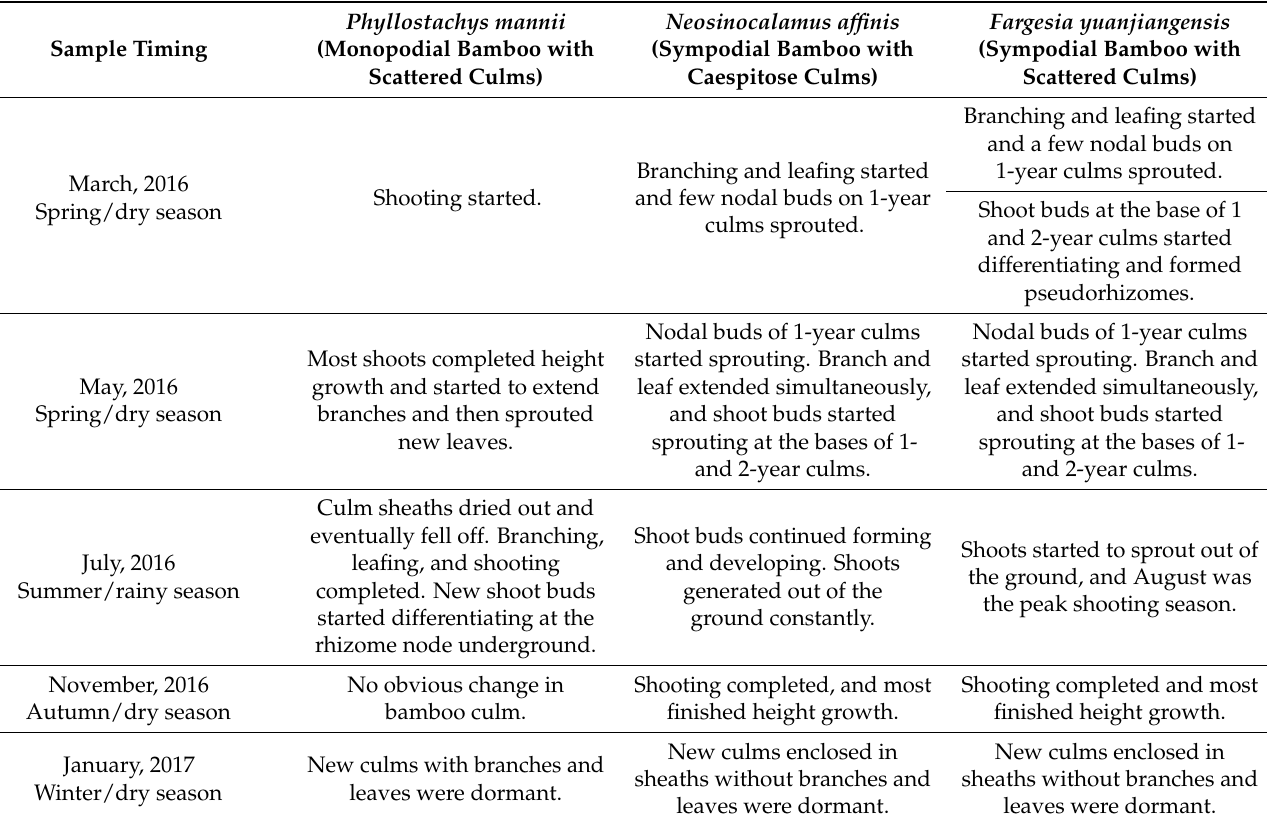
Table 1. Phenological characteristics of three bamboo